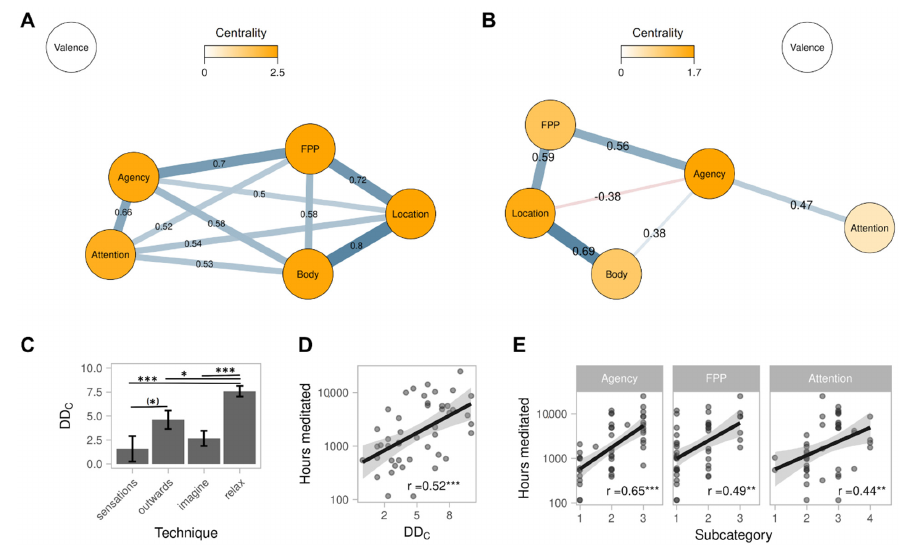
Figure 2. Quantitative relationships between phenomenological categories in the SB − condition. Panel ( A ): Network graph of the bivariate (Spearman) correlations between the phenomenological categories. Distances between nodes as well as the width and colouring of the edges reflect strength of association. Blue edges refer to positive and red edges to negative relationships. Edges are drawn only for significant correlations and size of the coefficients is plotted on top of the edges. Panel ( B ): Partial correlation network showing associations between nodes after controlling for all the other nodes in the network. Panel ( C ): Parameter estimates from a linear model predicting the computed degree of dissolution (DD C ) based on the employed meditative techniques. Error bars correspond to standard errors. Sensations = scanning sensations; outwards = turning attention outwards; imagine = imagination/memory; relax = relaxation, release, passivity (* p ≤ 0.05, ** p ≤ 0.01, *** p ≤ 0.001). Panel ( D ): Scatterplot and correlation coefficient (Spearman) showing the association between computed degree of dissolution (DD c ) and lifetime hours of meditative practice (on a logarithmic axis). Panel ( E ): Scatterplots for those phenomenological dimensions that correlated significantly with lifetime hours of meditative